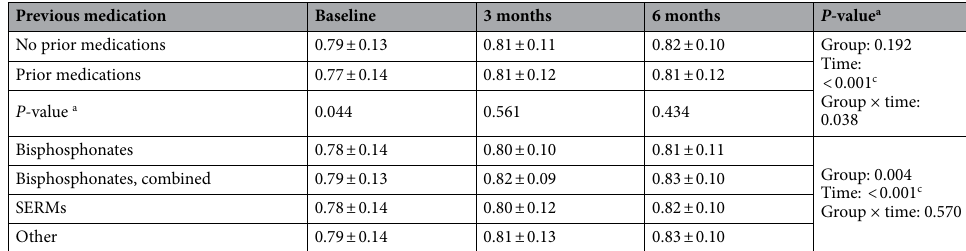
Table 3. Changes in quality of life assessed by EQ-5D index according to previous anti-osteoporotic treatment. Data are presented as mean ± SD. EQ-5D European Quality of Life Instrument 5 Dimensions, SERM selective estrogen receptor modulator. a By repeated measures analysis of variance. b Calculated by independent t-test. c Post hoc result by Bonferroni, there is a difference between all times ( P -value <